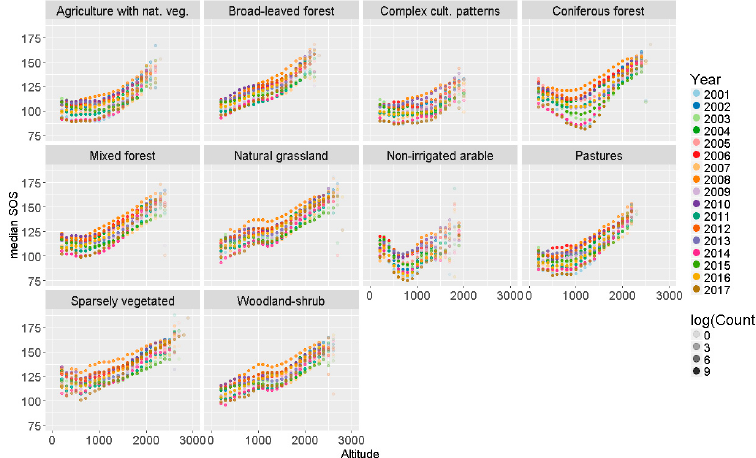
Figure 6 . Yearly alpine ‐ wide median SOS of the years 2001–2017 for the ten analyzed CORINE land covers. The amount of observations available per land cover class, year and altitude range is indicated by the transparency level of each dot, see “log(Count)”.